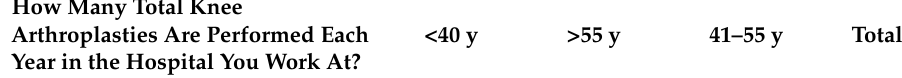
Table 2. Demographic data, workplace and number of total annual